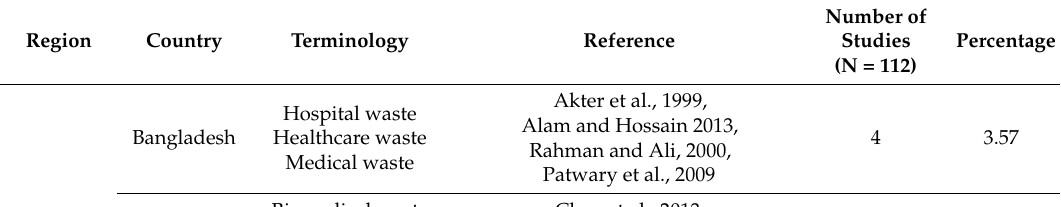
Table 1. A summary table for all low and middle-income countries (LMICs) and high-income countries (HICs) with various terminologies